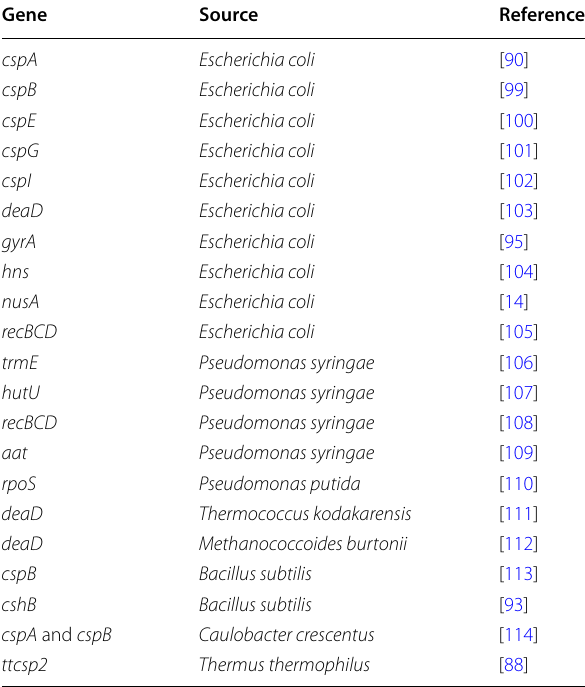
Table 2 Major genes upregulated by cold shock in